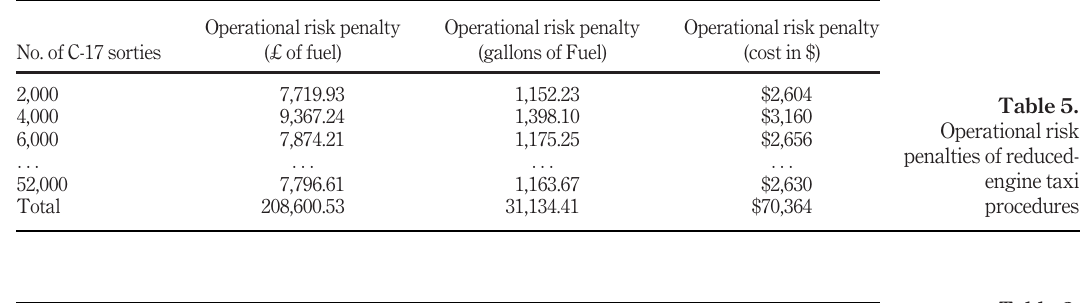
Table 6. Total fuel and cost